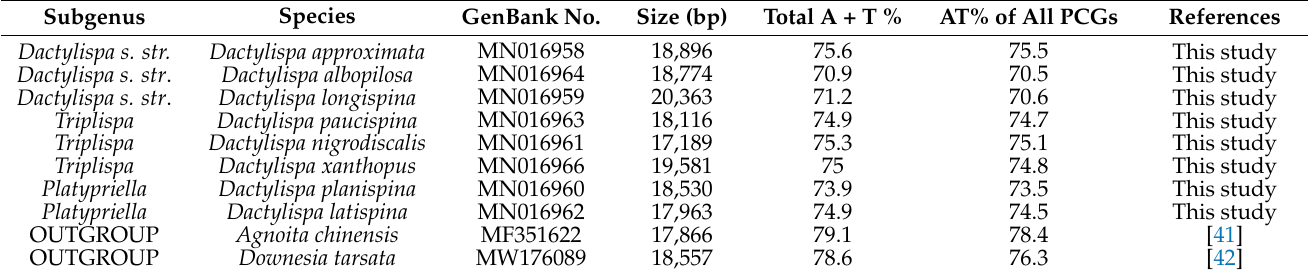
Table 1. List of taxa used for the phylogenetic analysis in this